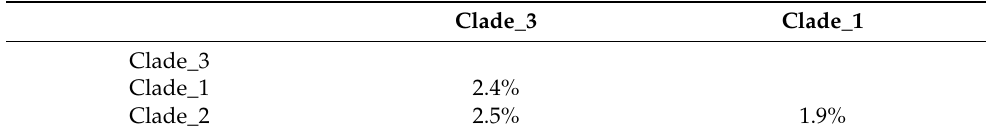
Table 1. Mean genetic distances (in %) of Clades 1–3 (see Figure 1) of frogs referred to as Limnonectes doriae based on the 16S dataset. See text for details.